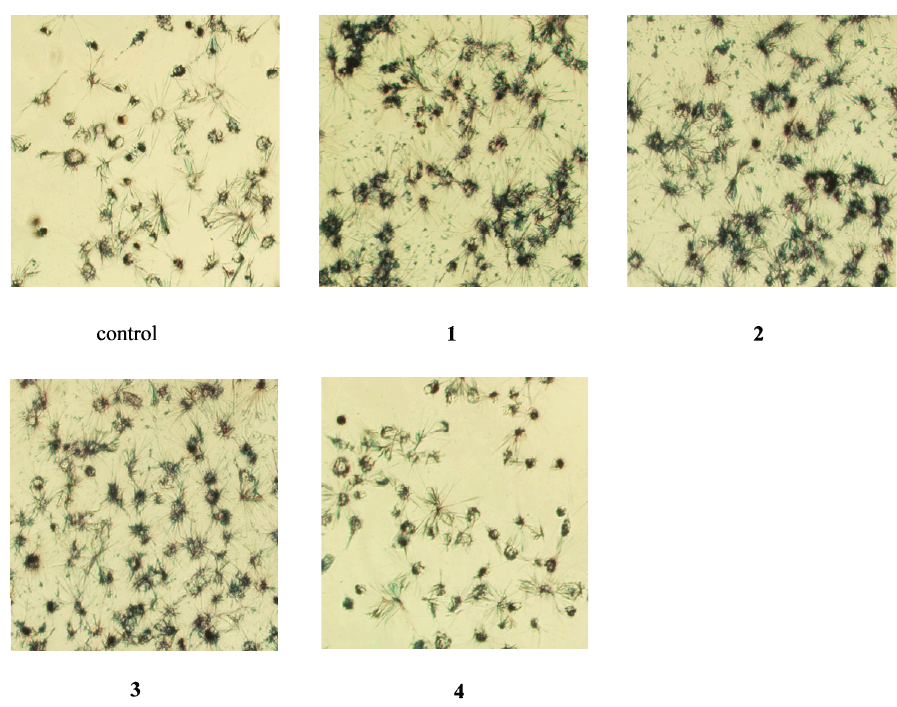
Figure 3. Micrographs showing formation of MTT formazan. EA.hy926 cells were treated with 50 μ M echinacoside ( 1 ), acteoside ( 2 ), caffeic acid ( 3 ), 3,4-dihydroxylphenylethanol ( 4 ) for 24 h. Magnification